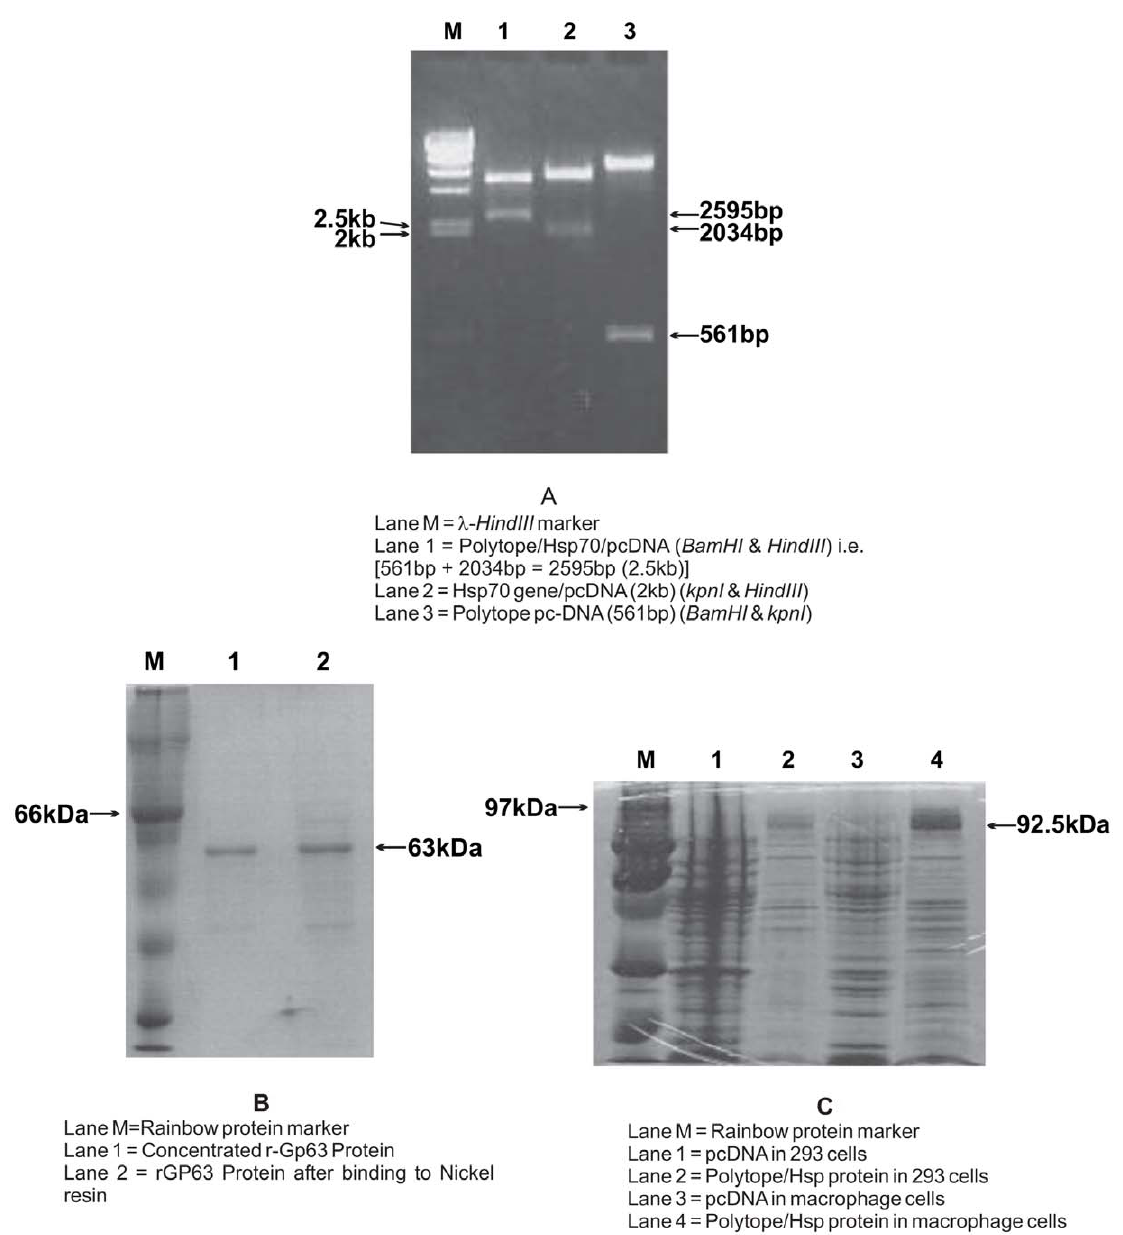
Figure 1. Construction of vaccine plasmids for DNA vaccination. ( A ) Polytope Vaccine design: The DNA sequence coding for the polytope antigen contained Kozak sequence, IgG k leader sequence, PADRE sequence and two T cell epitopes. Each epitope was separated with AAA nucleotides encoding lysine. This polytope gene was made by joining seven overlapping oligonucleotides using splicing by overlap extension and PCR and was cloned into BamHI and kpnI restriction sites of pcDNA3.1 vector. The Poly/pcDNA encoded Polytope antigen (Polytope DNA vaccine), Poly/hsp/pcDNA encoded hsp70-fused polytope antigen (Poly/hsp DNA vaccine). ( B ) Nucleotide sequence of final product of Polytope DNA which showed 100% homology to designed sequence. ( C ) Restriction digestion of vaccine plasmid constructs to confirm the presence of insert gene sequences. ( D ) SDS-PAGE (12%) analysis of invitro expression of Polytope antigen fused with hsp70 in J774A.1 macrophages and 293 cells.